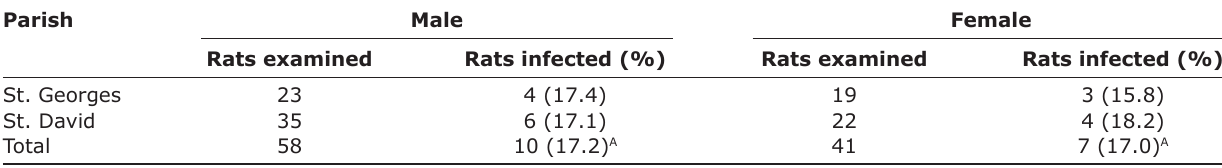
Table-4: Prevalence of coproantigens of Giardia in the intestinal content of brown rats from Grenada.